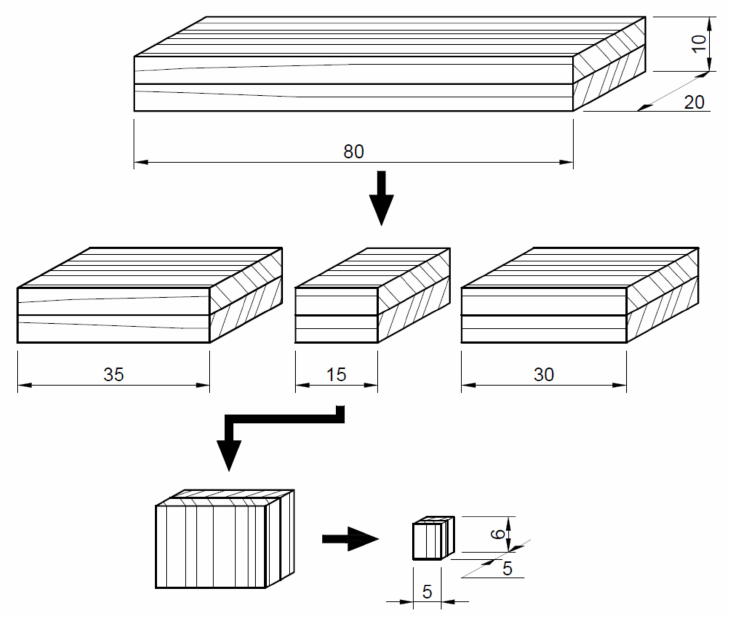
Figure 2. Preparation of the micro-plate (6 mm × 5 mm × 5 mm) for microscopic analysis of the “wood—PUR” interphase.